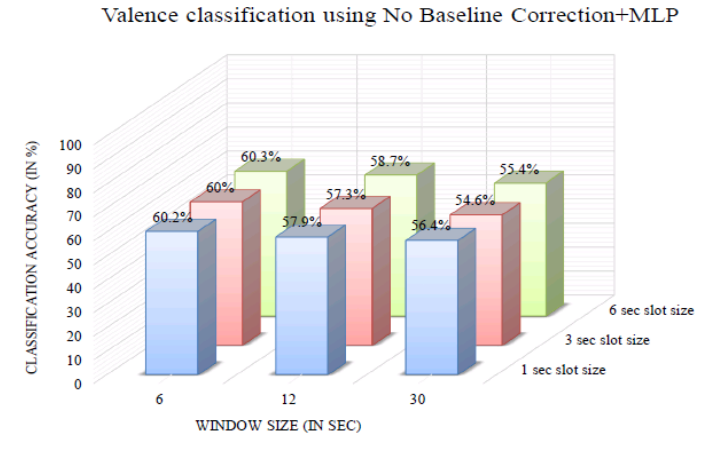
Figure 11. Valence classification accuracy of NBC+MLP method for variouswindow